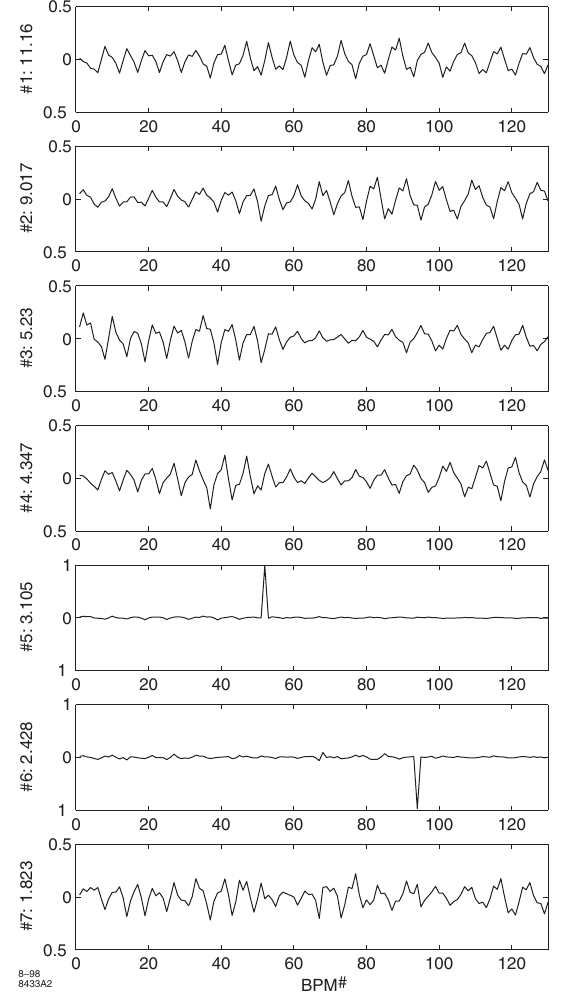
FIG. 5. Singular U-vectors derived from free betatron oscil- lation data in the SLC. The top four singular vectors represent the betatron oscillations while the singular vectors 5 and 6 show uncorrelated signals originating from malfunctioning